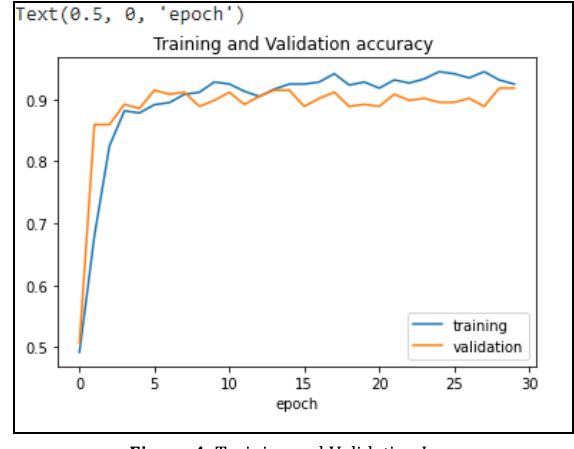
Figure 4: Training and Validation Loss